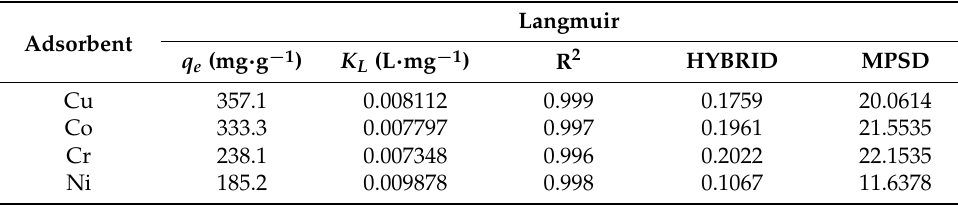
Table 5. Isotherm parameters and error functions for adsorption of heavy metals onto poly(hydroxamic acid) ligand.